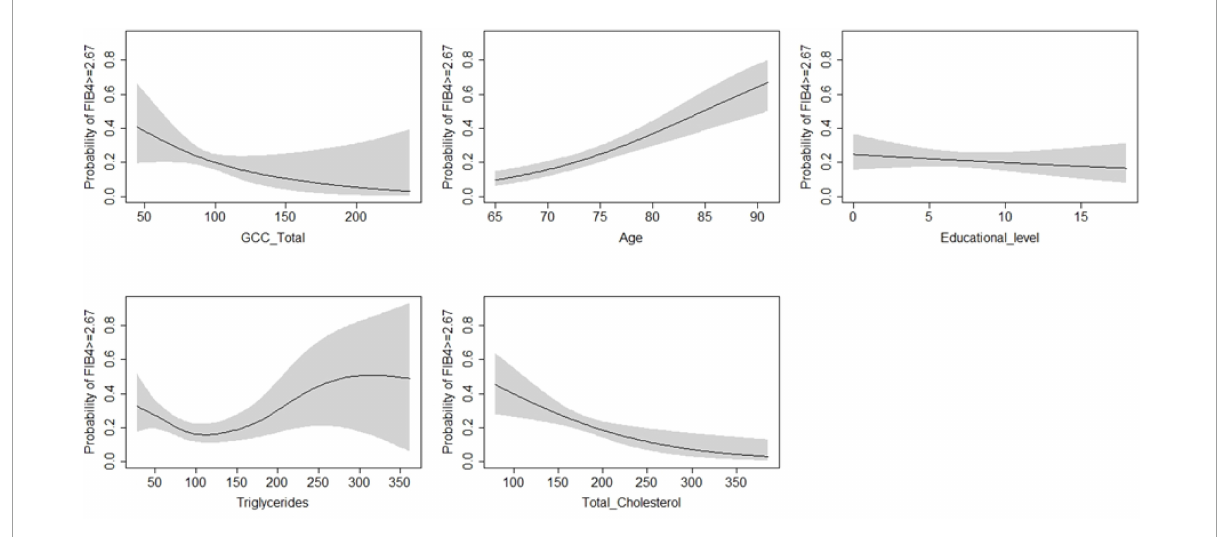
FIGURE2 Generalized additive model on the probability of FIB-4 ≥ 2.67 (fibrosis/no fibrosis) as dependent variable and